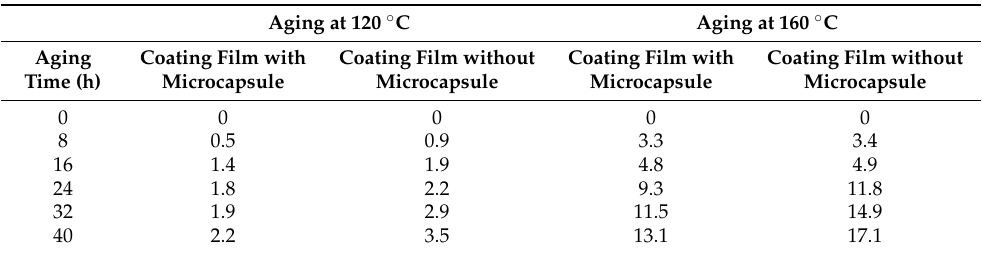
Table 6. Chromatic aberration of coating film under high temperature aging